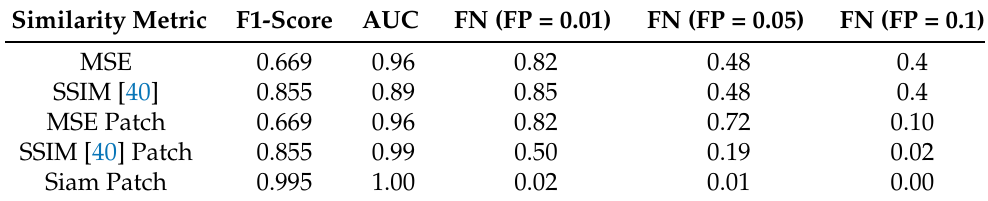
Figure 11. Receiver operating characteristic curves of similarity metrics with geometric coincident image pair or patch pairs. Patch means a similarity metric uses multiple patches sampled from an image as inputs. The pink curve (ROC of mse) is same as the cyan curve (ROC of mse_patch). Table 5. Similarity metric performance with geometric coincident image pair or patch pairs. Patch means a similarity metric which uses multiple patches sampled from an image as inputs. FN and FP are False Negative and False Positive,